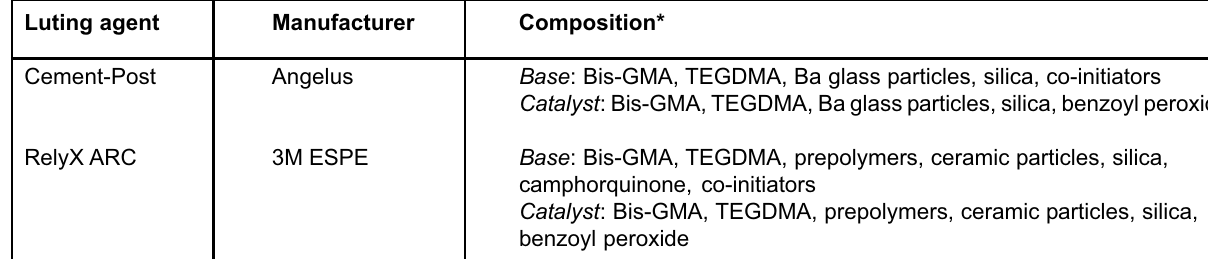
FIGURE 1- Resin luting agents used in the study *Information supplied by the